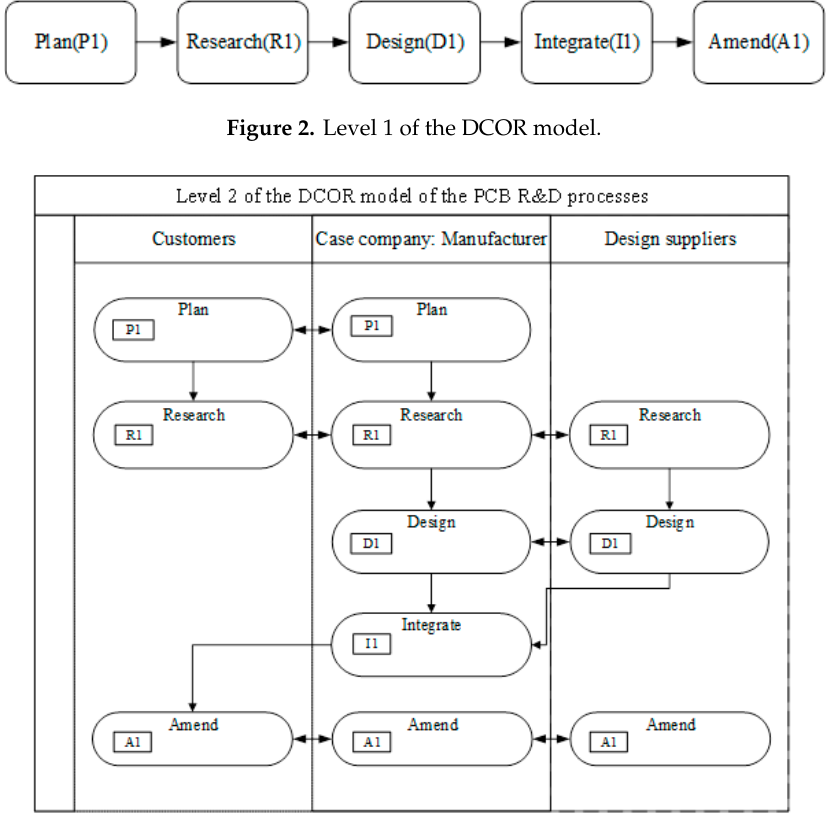
Figure 3. Level 1 of the DCOR model of the PCB R&D processes.